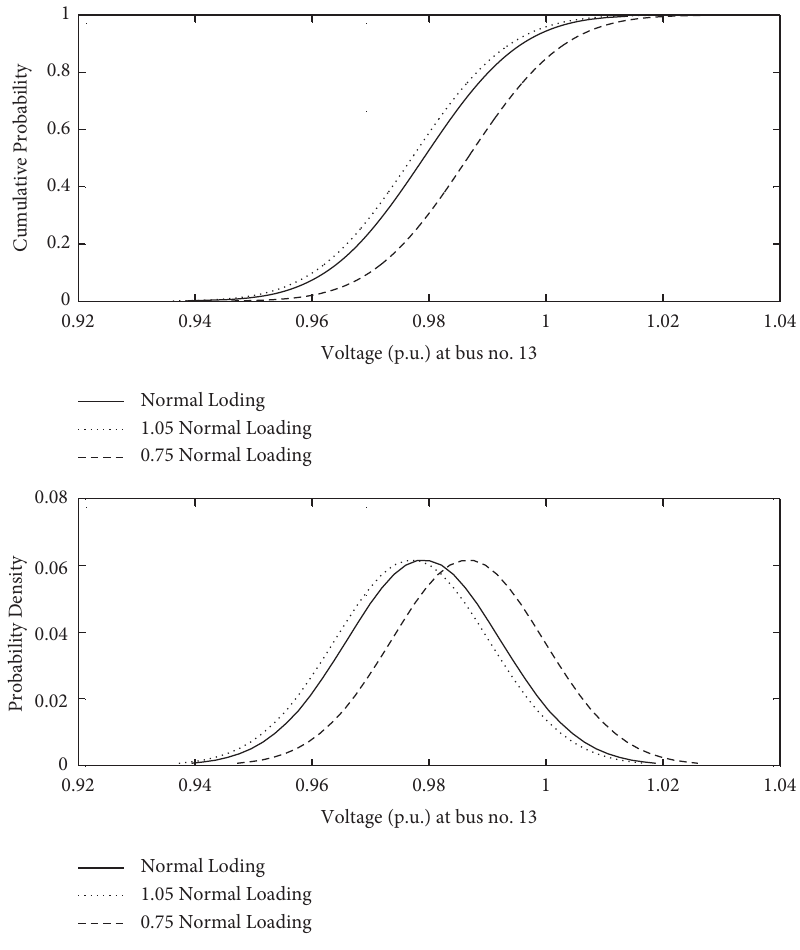
Figure 6: CDF and PDF of voltage at bus no. 13 for diferent values of loadings.